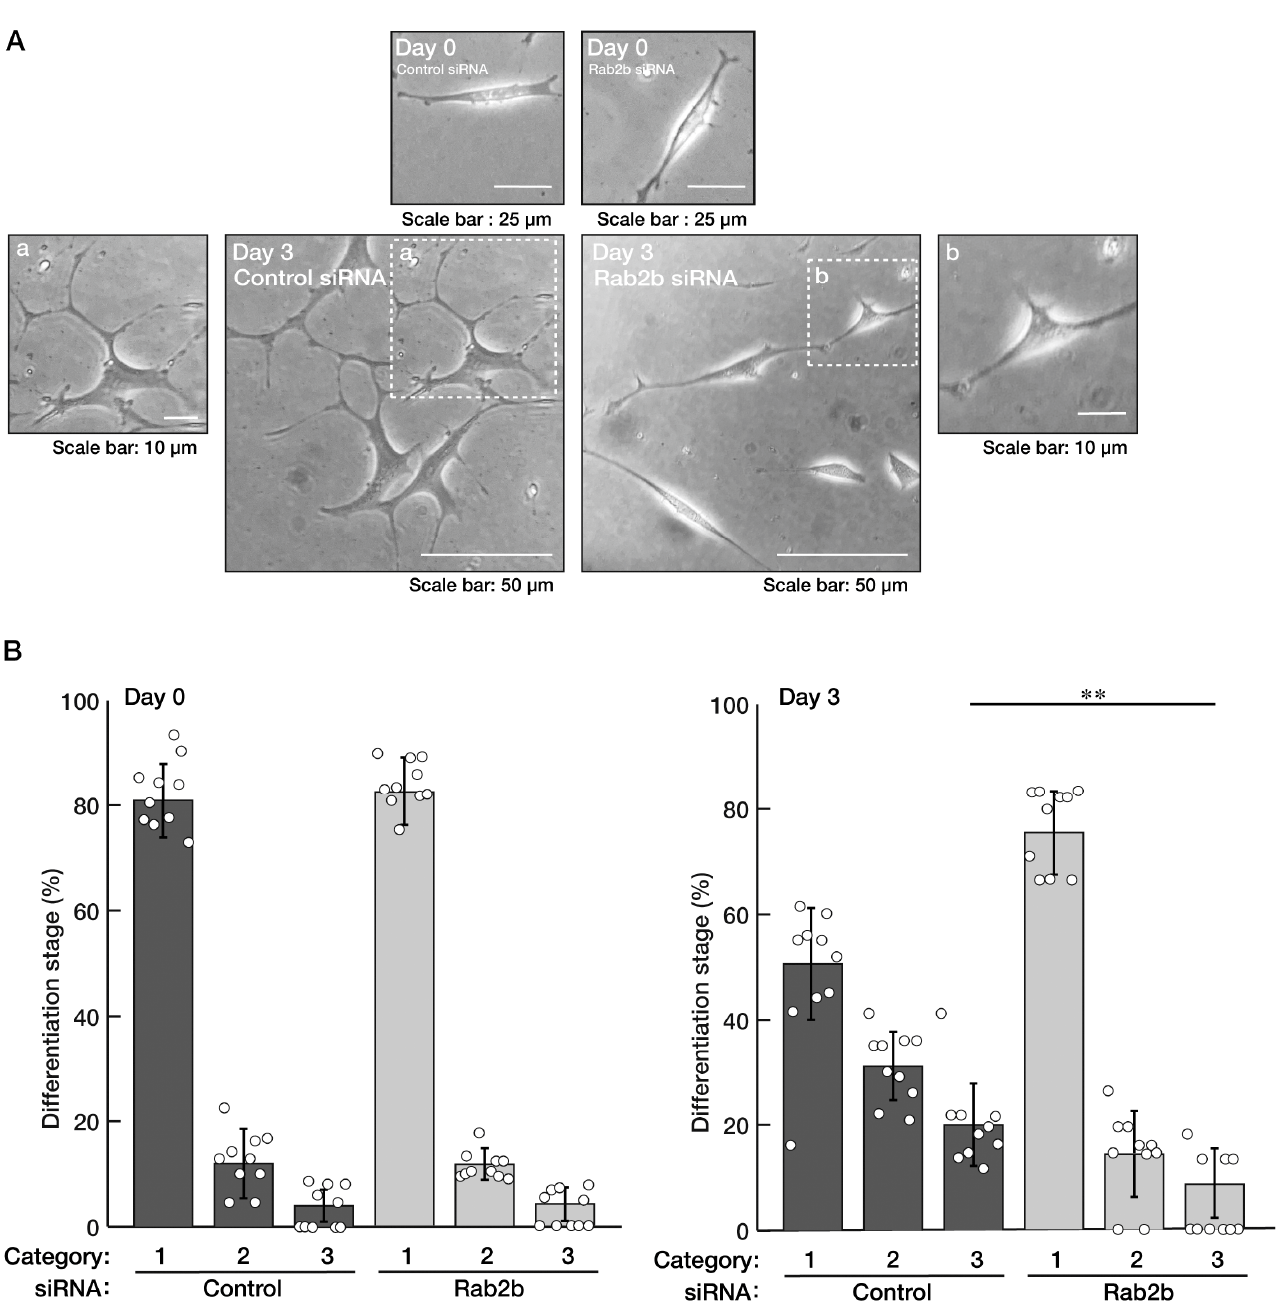
Figure 7. Knockdown of Rab2b decreases morphologically differentiated phenotypes in FBD-102b cells. ( A , B ) FBD-102b cells were transfected with a control or Rab2b siRNAs. Transfected cells were allowed to be cultured for 0 or 3 days following the induction of differentiation. Their cell morphologies were divided into 3 categories and statistically depicted as graphs (** p < 0.01; n = 10 fields). A differentiated phenotype as complexity of branches is shown to be increased in the order of categories 1 to 3. White circles show percentages in the respective independent experiments.